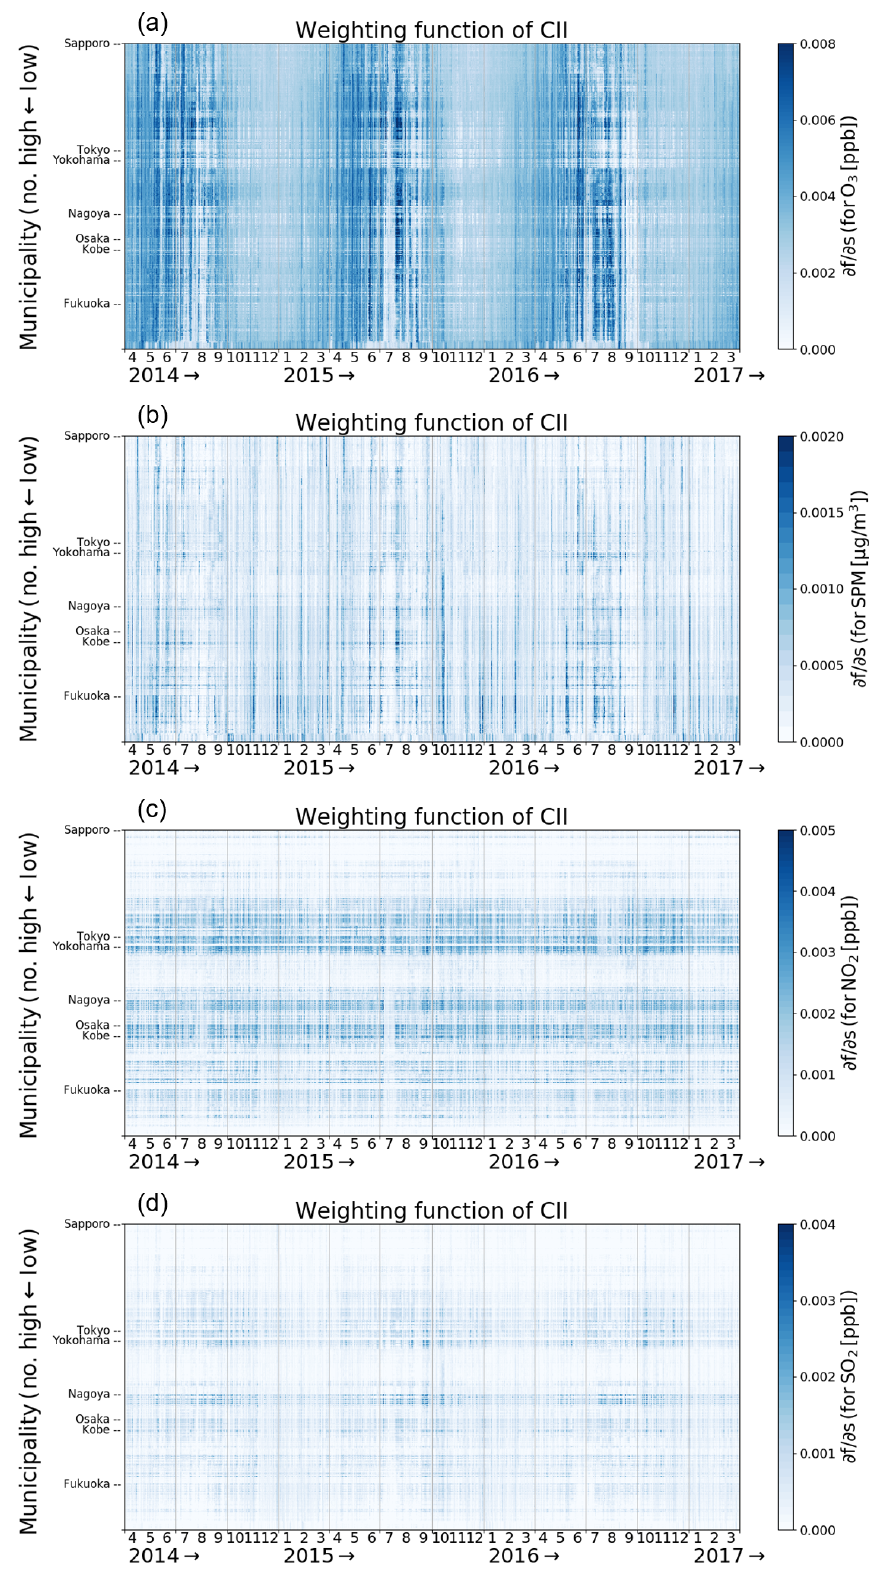
Figure 3. Spatiotemporal variation of the weighting function for the numerical criteria, K s , for (a) O 3 , (b) SPM, (c) NO 2 , and (d) SO 2 derived from the WRF–CMAQ model. The color scaling is optimized for each